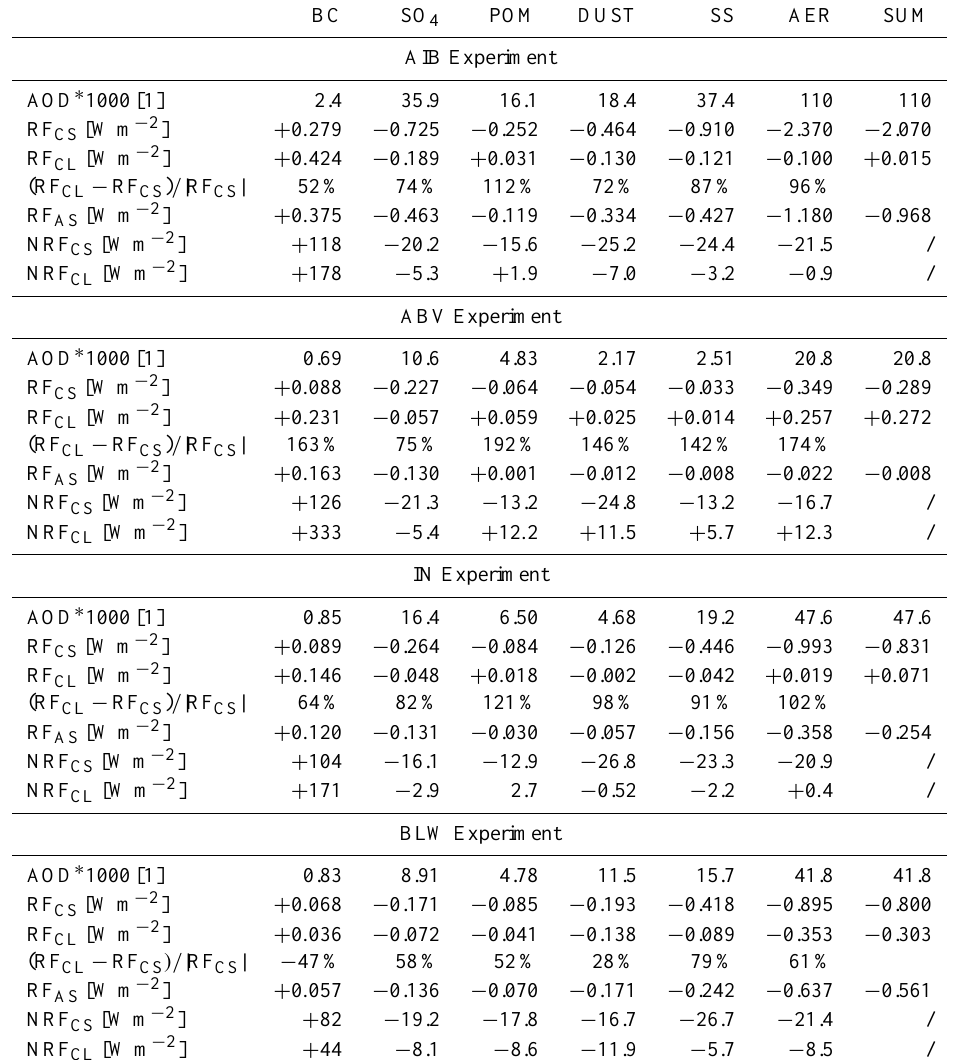
Table 3. Optical depth and forcings in four experiments with aerosols above + inside + below clouds (AIB), only above (ABV), only inside (IN) and only below clouds (BLW) using the default configuration. Averages exclude completely clear columns. Abbreviations as in Table